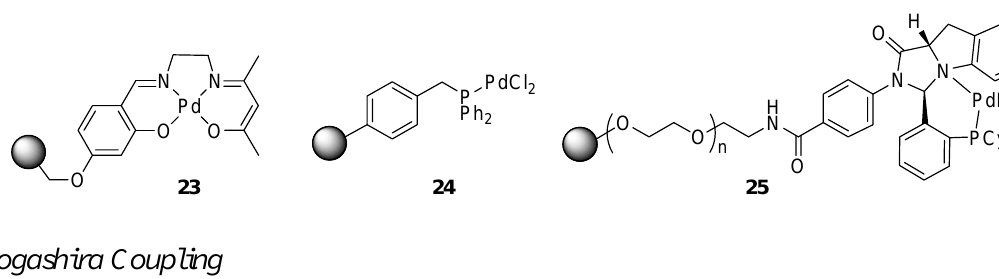
Figure 1. Supported catalysts developed for Suzuki reactions in